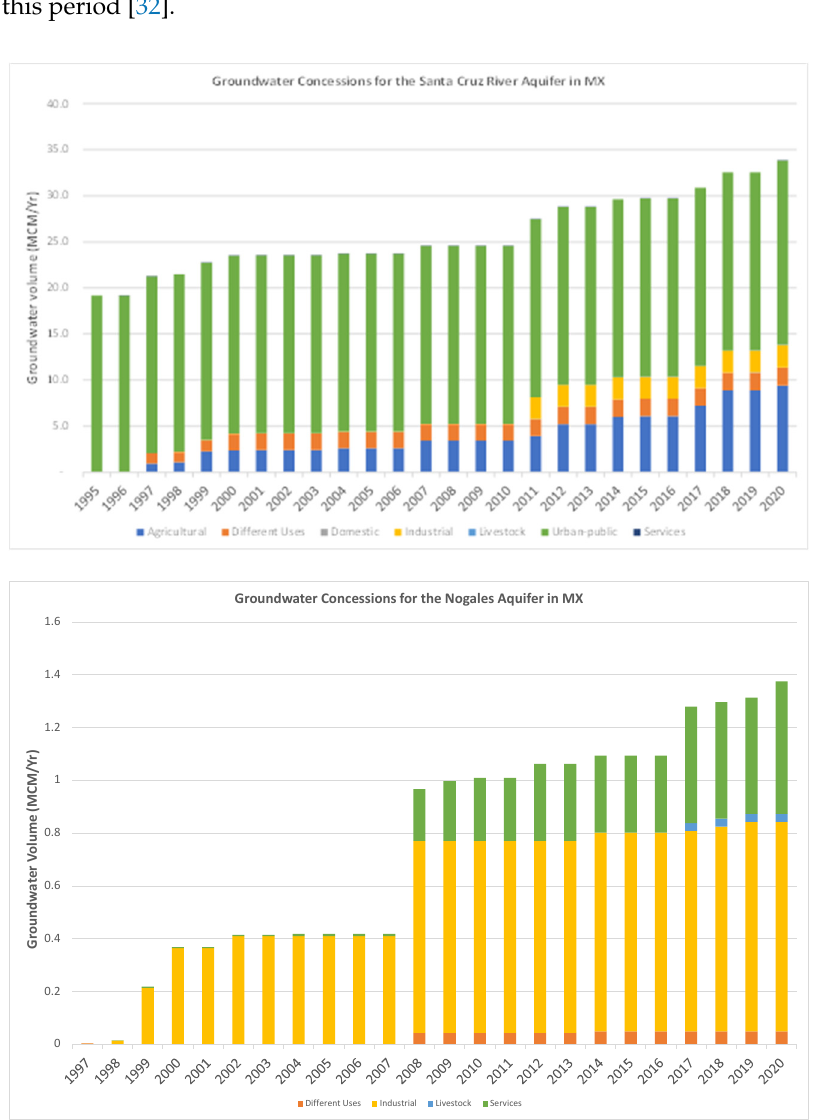
Figure 2. Groundwater Concessions ( Asignaciones) in the Santa Cruz River Aquifer in Mexico and the Nogales Aquifer. Source: REPDA (2020) [30].